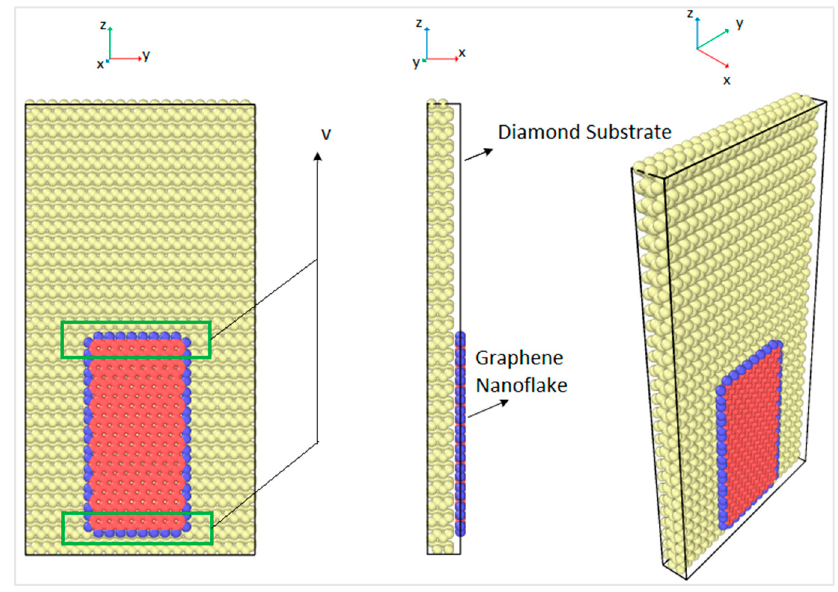
Figure 1. Molecular dynamics model and the loading scheme.